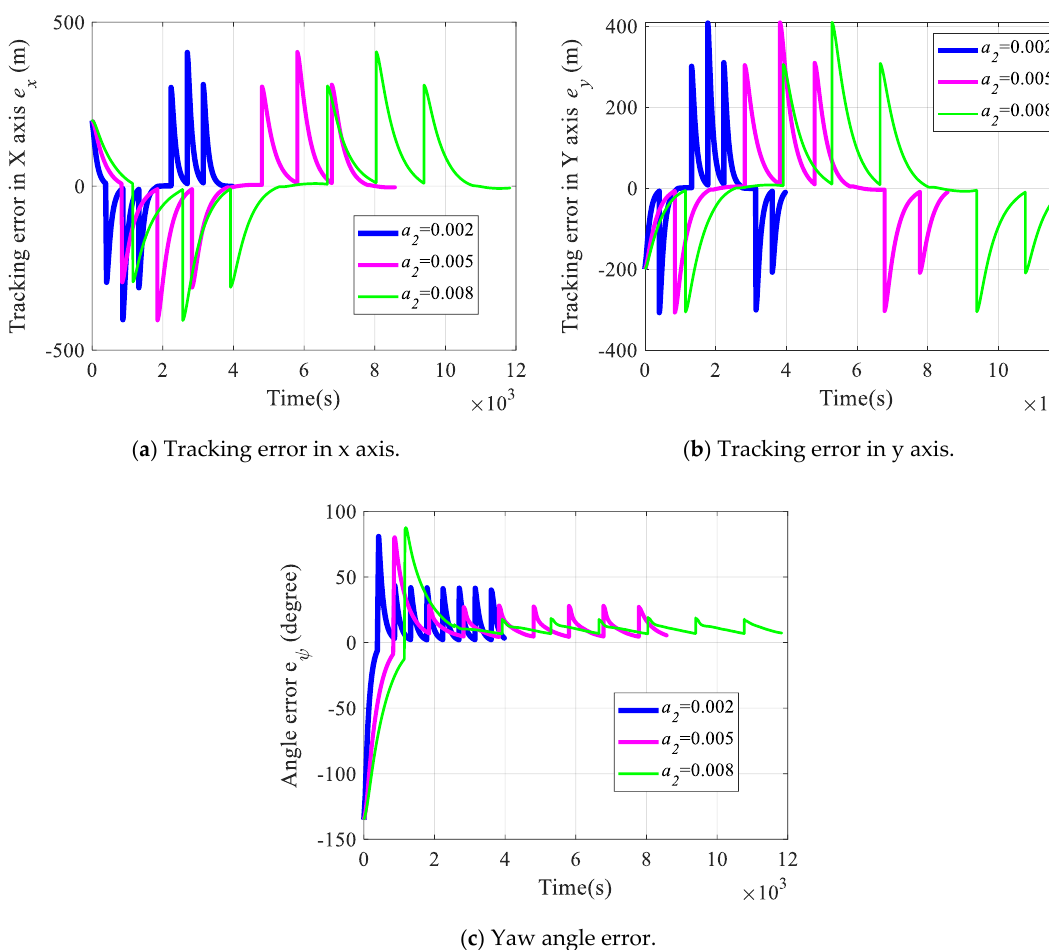
Figure 14. Tracking courses: waypoint-tracking scenario with respect to different control gains